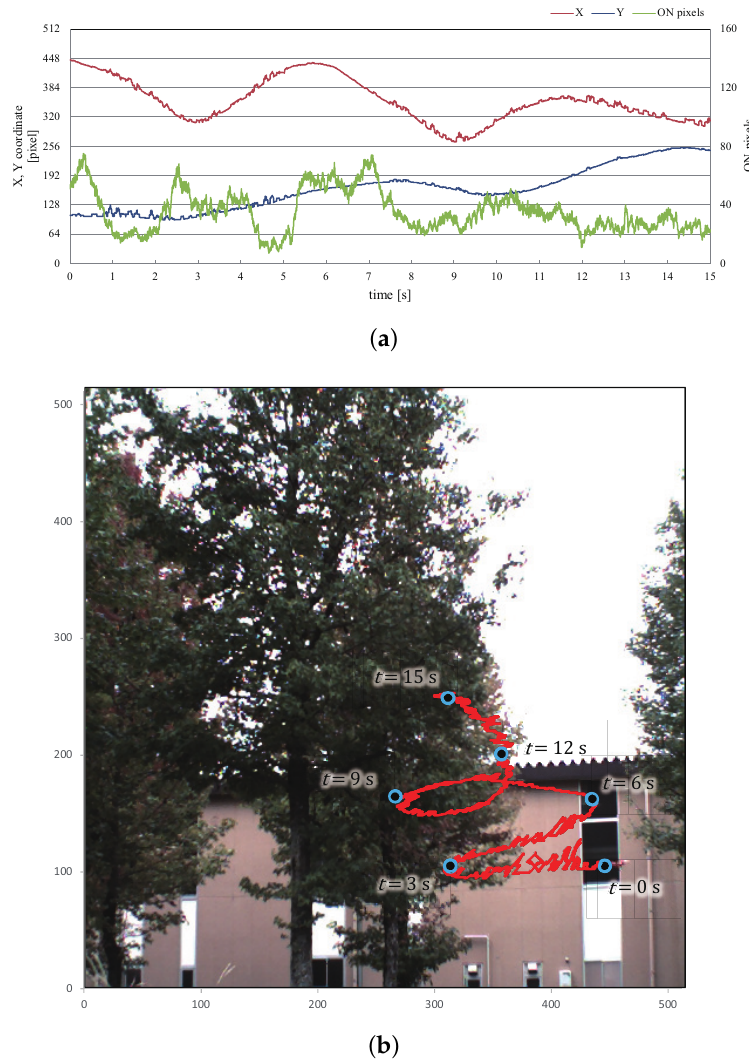
Figure 20. xy trajectory of extracted vibration region in “trees-and-building background” experiment. ( a ) x - and y -coordinates and number of pixels; ( b ) xy